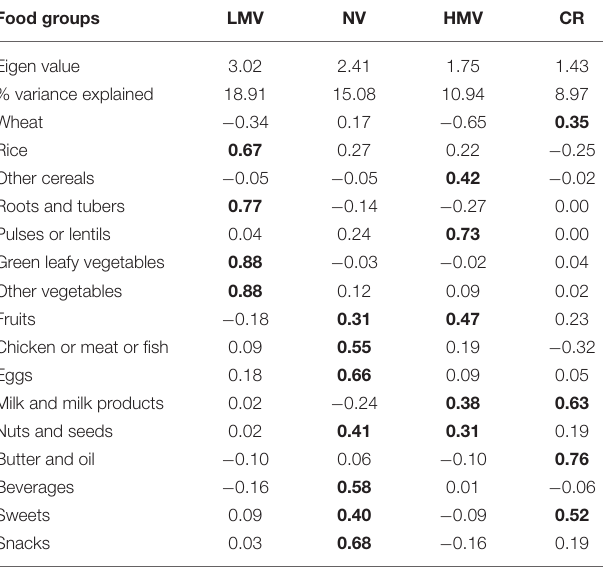
rotated principal components for women. Food